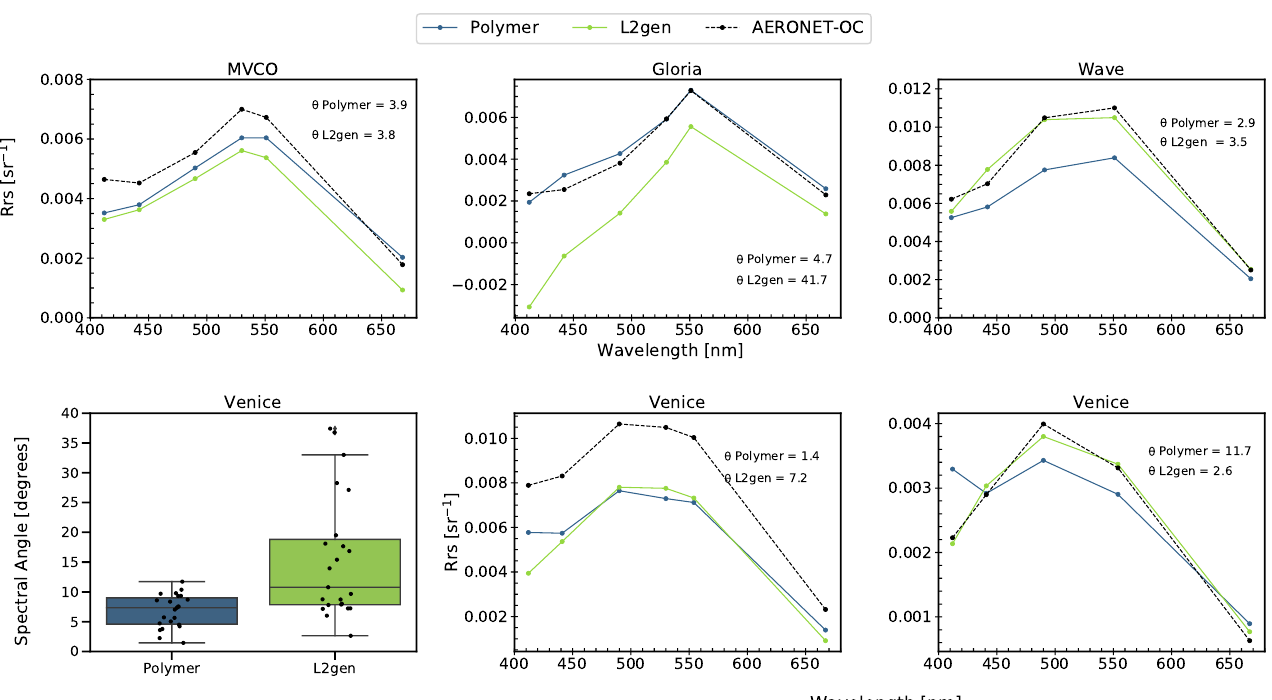
Figure 7. Top: Spectra of coincident match-ups of HICO-Polymer, HICO-L2gen, and AERONET-OC at MVCO, Gloria, and Wave sites (N = 1). Bottom left: boxplots of spectral angle for each AC algorithm at the AERONET-OC Venice site (N = 22). Center lines show the medians, box limits indicate the 25th and 75th percentiles, whiskers extend 1.5 times the interquartile range, and the spectral angle data are represented by data points on top of the boxes. ( Bottom center and right ): spectra of coincident match-ups of HICO-Polymer and HICO-L2gen at AERONET-OC Venice for the lowest and highest Polymer spectral angles.